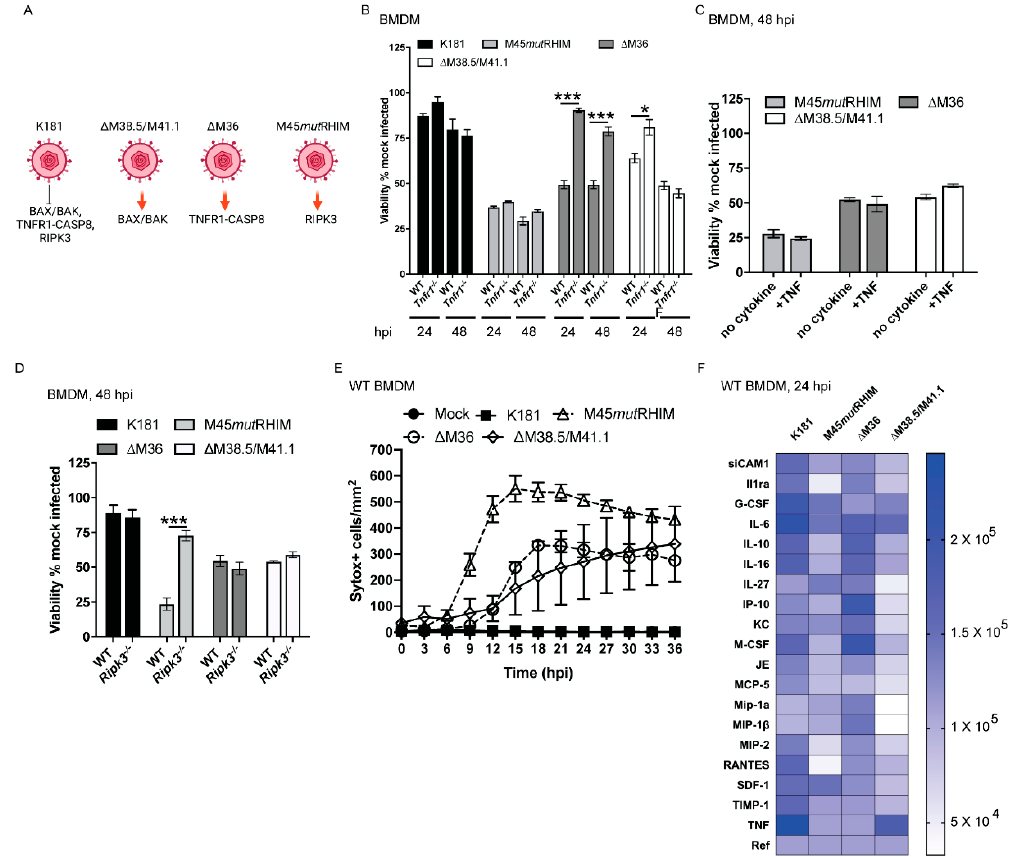
Figure 3. Characterization of MCMV-dependent suppression of apoptosis and necroptosis. ( A ) Pictorial representation generated using BioRender software depicting the cell death suppressor pathways recognized to function in MCMV-infected macrophages. ( B – D ) Viability measured at indicated times post infection with K181 or ∆ M38.5/M41.1 (MOI = 10) in WT and Tnfr1 − / − BMDM ( B ), or WT BMDM treated with TNF (25 ng/mL) 1 hpi ( C ), or WT and Ripk3 − / − BMDM ( D ). Each bar represents pooled data obtained from minimum of three experiments. Horizontal lines indicate the two groups being compared by Wilcoxon matched-pairs signed rank test. * is p < 0.05; *** is p < 0.001. Only significant differences are indicated by horizontal lines in panels. ( E ) Viability of WT BMDM infected with K181, ∆ M36, M45mutRHIM, or ∆ M38.5/M41.1 MCMV assessed by inclusion of cell-permeable dye (Sytox Green) over the indicated timecourse. Each graph represents the pooled data from two independent experiments. Error bars indicate the standard error and mean for each dataset. ( F ) Heat map depicting a broad survey of cytokines and chemokines detected in cell-free supernatant from WT BMDM infected with the indicated viruses for 24 h. Each group contains pooled supernatants from two independent experiments. Scale bar on the right indicates range intensity of the cytokine signal. Reference (Ref) is generated from average of three reference points located on dot blot (see Figure S4). For each mutant infection setting, references are normalized with respect to K181 infection.